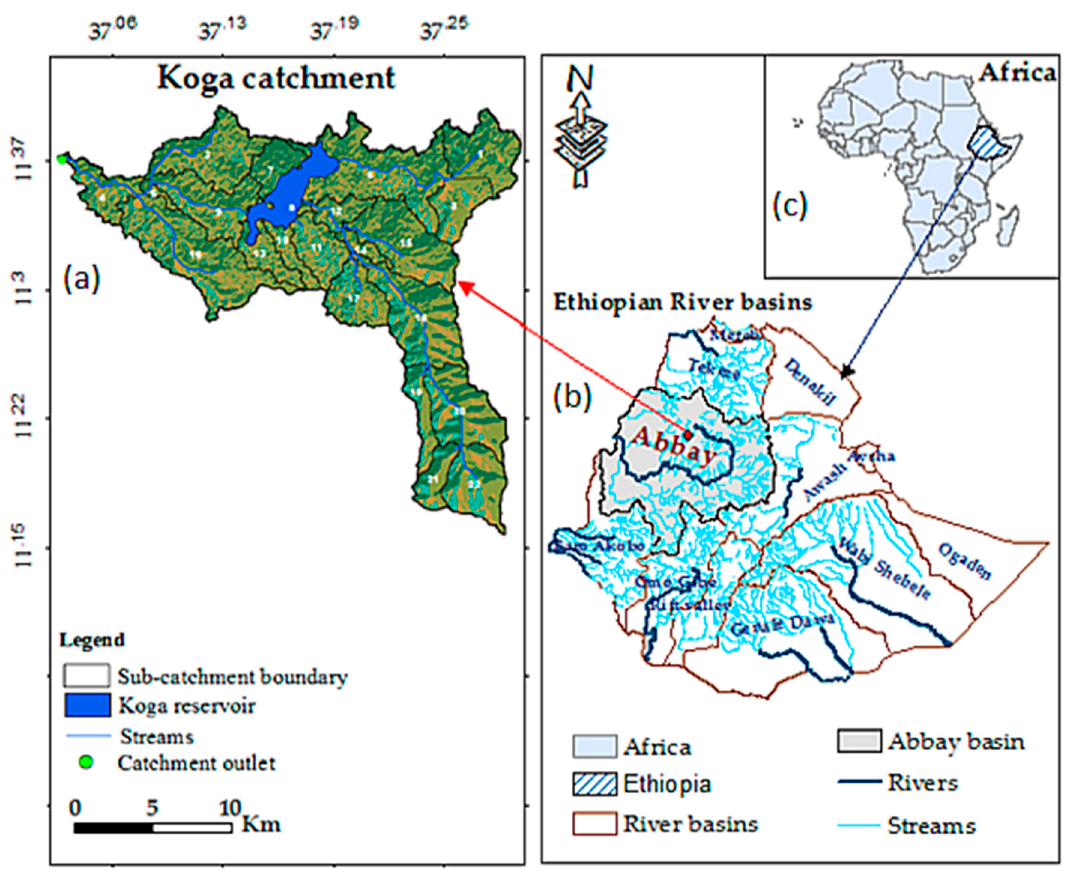
Figure 1. Location map of the study area: the geographical setting of the Koga watershed ( a ) and location of the study area in the Abbay basin with a network of rivers and streams ( b ); and country map of Africa ( c ).